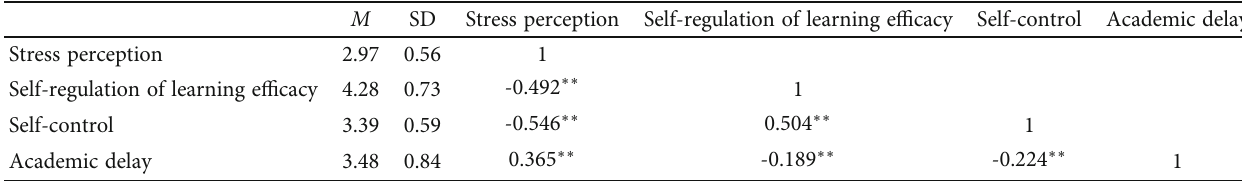
Table 3: Correlation analysis of variables.